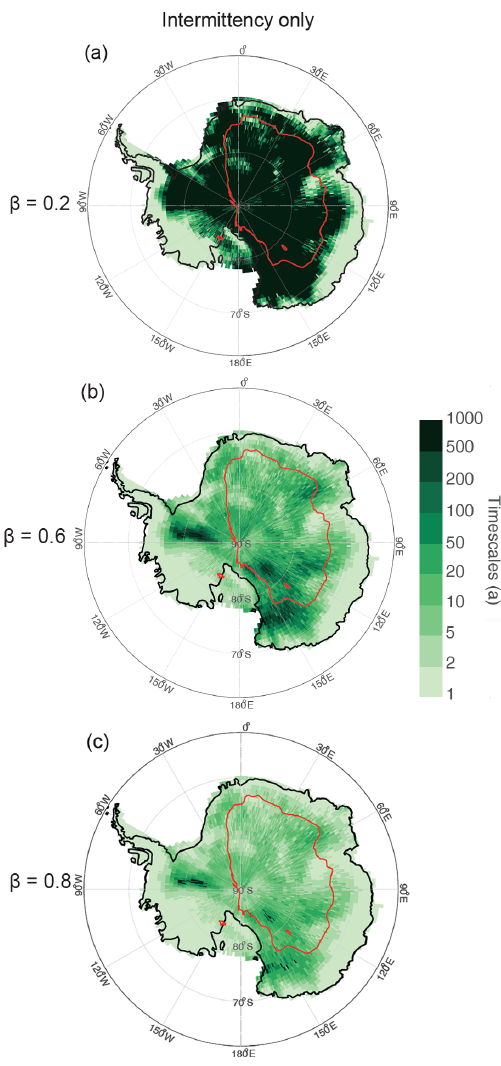
Figure 5. Maps of the signal retrieval timescales τ a after block av- eraging for the case of precipitation intermittency only and for cli- mate spectrum scaling exponents of (a) β = 0 . 2, (b) β = 0 . 6, and (c) β = 0 . 8. The red line marks the contour of an accumulation of 25cmw.e.; see also Fig.